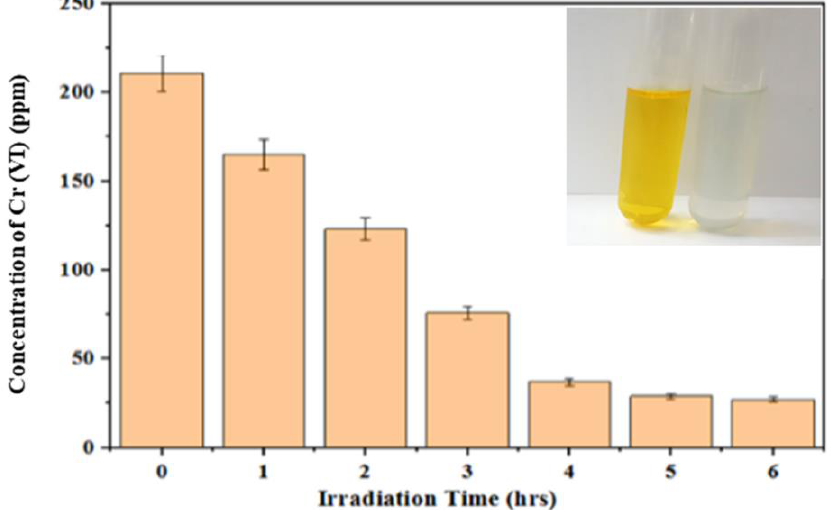
Figure 12. Irradiation time vs. concentration of the Cr(VI) for ZnO/CuO/PMR (inserted image indicate real wastewater before (yellow coloured solution) and after treatment (a clear solution). Reprinted from [59].